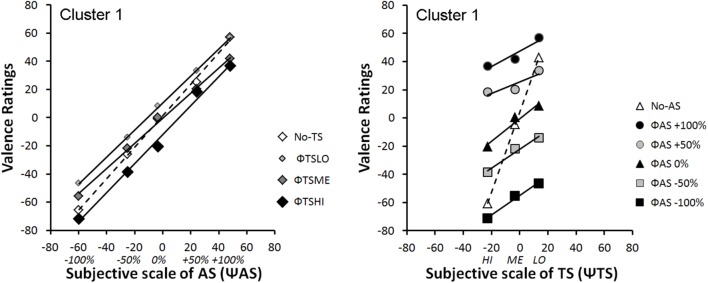
Mean integration graphs of Cluster 1 participants as a function of their subjective (Ψ) scaling for each stimulus category.